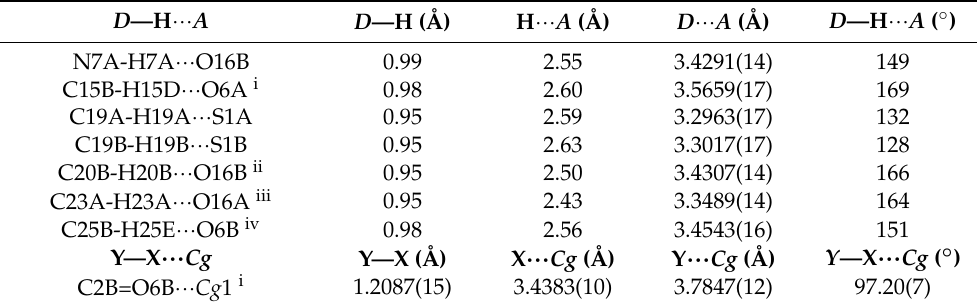
Figure 3. Overlay of two symmetry-independent molecules—A (red) and B (blue)—by the least- squares fitting of the thiazolidin-2,4-dione systems.